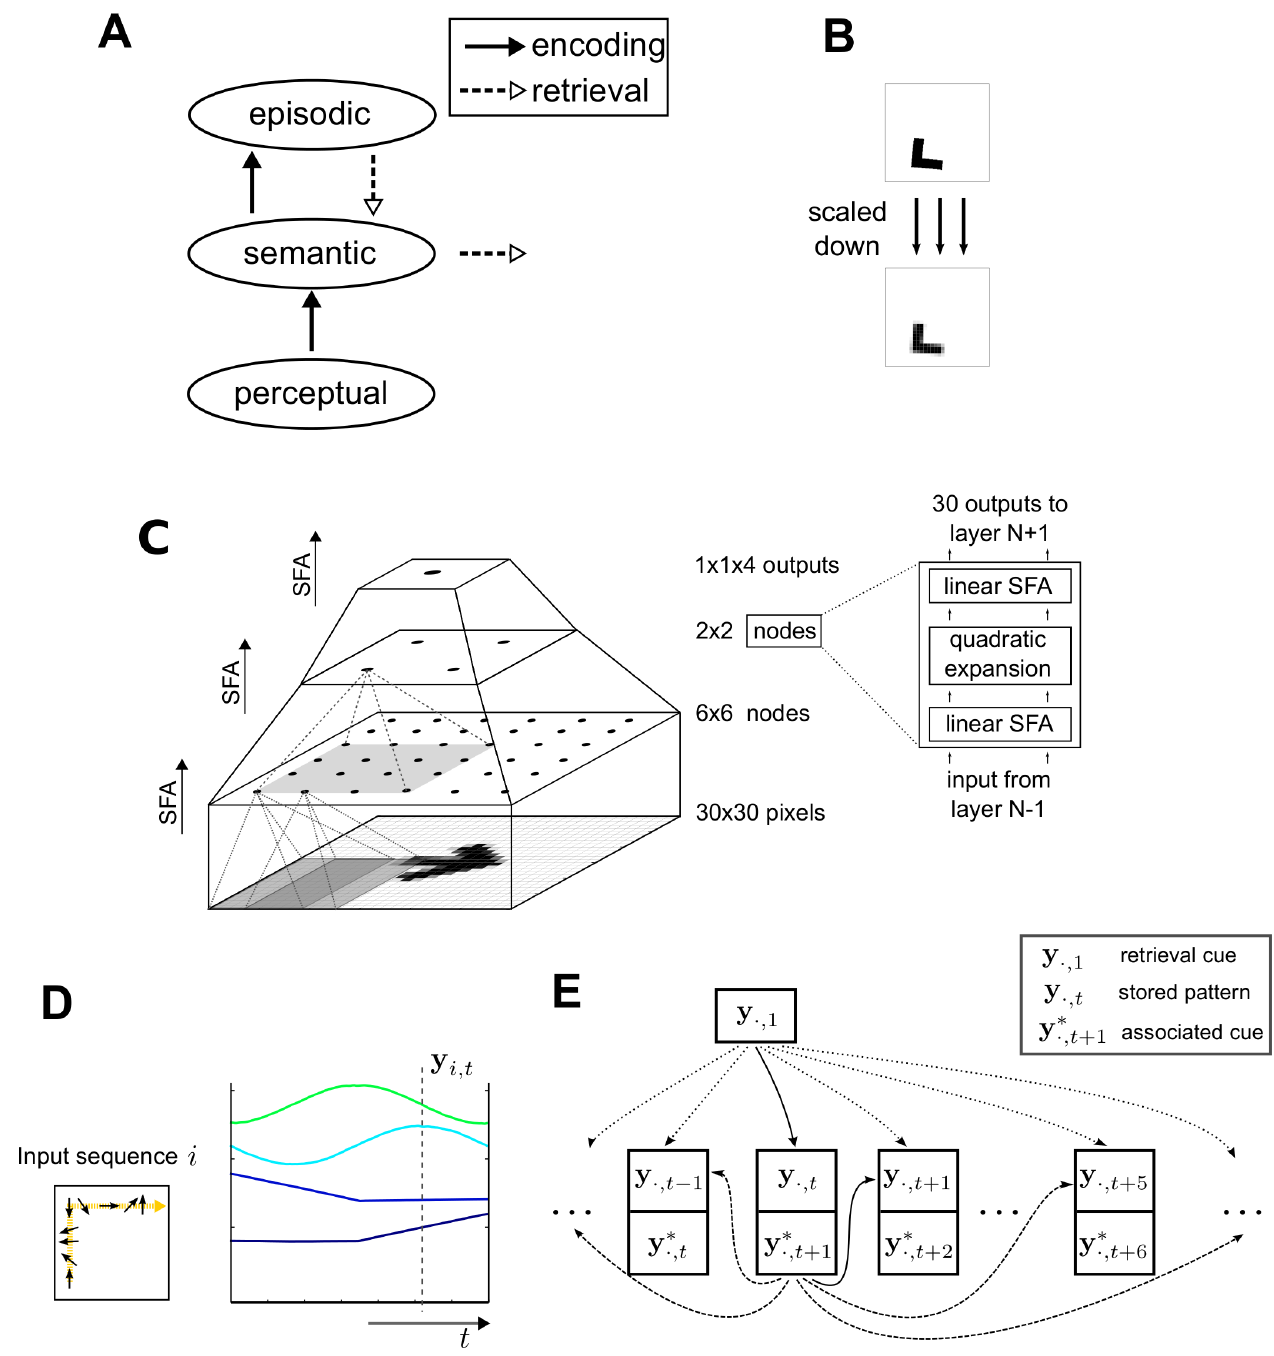
Fig 1. Schematic of the episodic memory model. A. The relationship between systems involved episodic memory. B. Example of the input stimuli. Top: 300 × 300 black-and-white pixels; bottom: pattern scaled down to 30 × 30 greyscale pixels. C. Hierarchical network of slow feature analysis (SFA) as a model of the semantic system. The dots in each layer symbolize SFA nodes. The grey patches indicate the receptive field of each node, partially overlapping with the neighbouring nodes’ receptive fields. As an ensemble nodes in a given layer cover the full input space. Each node performs a number of processing steps as visualized on the right hand side. The activity in the top layer is taken as the output of the semantic system in our memory model. D. Example of the output of the semantic representation layer. The object in the input sequence i moves along the trajectory (yellow arrow) and rotates by 360 degrees (indicated by black arrows). Shown on the right are the four slowest features calculated by the SFA-network. The feature values at time t , y (dashed line), form a semantic (more abstract) representation of the input. i , t E. Sequence storage network (see main text in Methods for details).